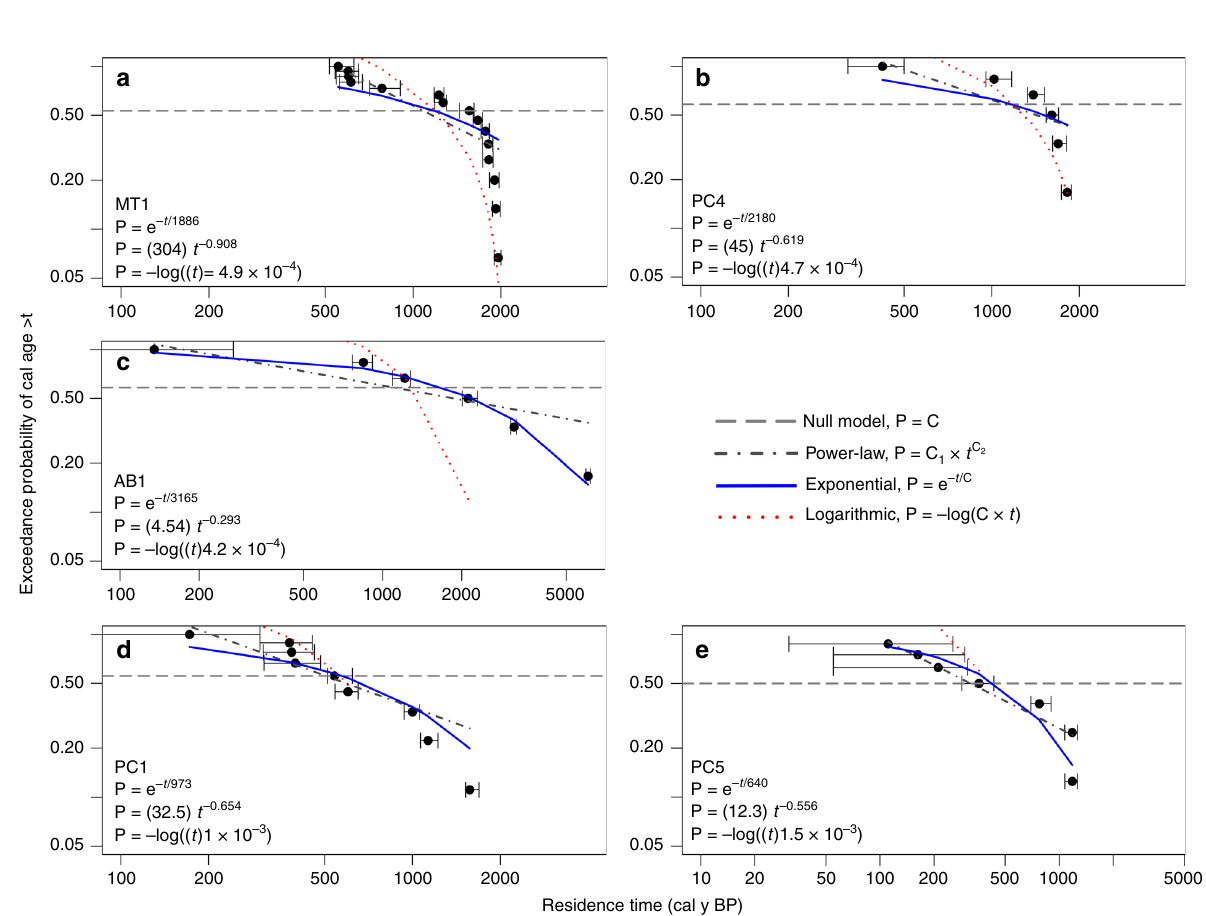
Fig. 2 Exceedance probability (P) of weighted mean calibrated 14 C ages. Plots are presented for sites with a suf fi cient number of ages to warrant examination of the age distributions as an estimate of residence time ( t ). Solid black circles indicate weighted mean ages and error bars represent the minimum and maximum values for each sample at the 95.4% con fi dence level. Equations for power-law, exponential, and logarithmic fi ts where R 2 represents the proportion of variance explained by a linear regression between predicted and observed values of P and RMSE is root mean square error. The exponential, power-law, and logarithmic models resulted in R 2 = 0.89, 0.82, and 0.88 and RMSE = 0.154, 1, 0.238 for MT1 a , R 2 = 0.83, 0.67, and 0.76 and RMSE = 0.174, 0.164, and 0.292 for PC4 b , R 2 = 0.99, 0.80, and 0.91 and RMSE = 0.037, 0.130, and 0.938 for AB1 c , R 2 = 0.94, 0.85, 0.94, and RMSE = 0.109, 0.113, 0.371 for PC1 d , and R 2 = 0.94, 0.95, and 0.96 and RMSE = 0.067, 0.054, and 0.655 for PC5 e , respectively. Source data